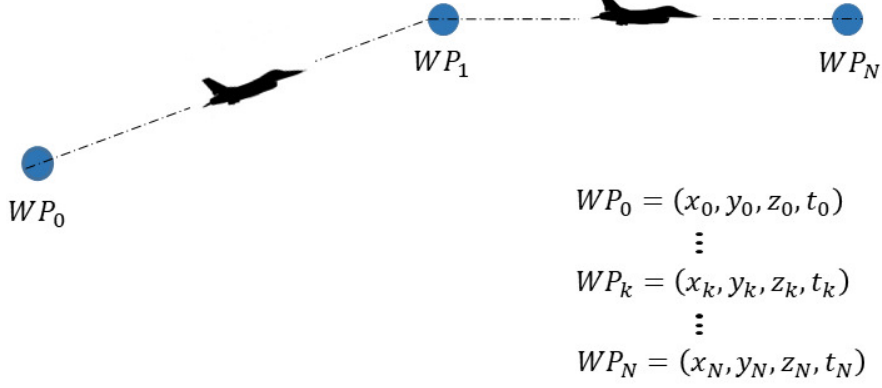
Figure 2. Aircraft fly towards 4D waypoints